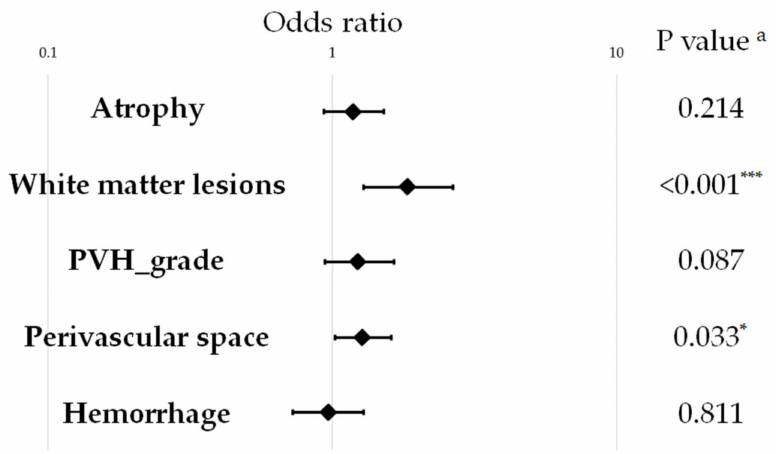
Figure 3. Association between brain structure and visceral fat area using magnetic resonance imaging. Data are presented as the odds ratio and 95% confidence intervals. a p value was adjusted using logistic regression, adjusting for age, sex, muscle mass, education, smoking, body mass index, exercise habits, alcohol consumption, and prevalent confounding diseases (depression, hypertension, hyperlipidemia, and diabetes). * p < 0.05; *** p <